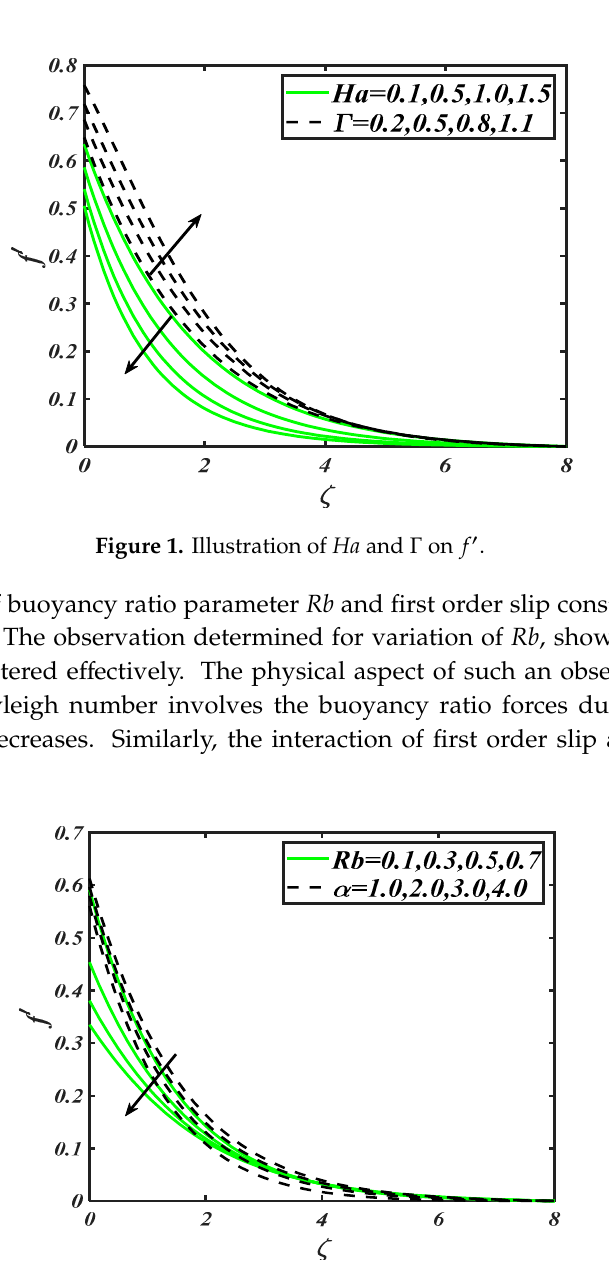
Figure 2. Illustration of Rb and α on f (cid:48)